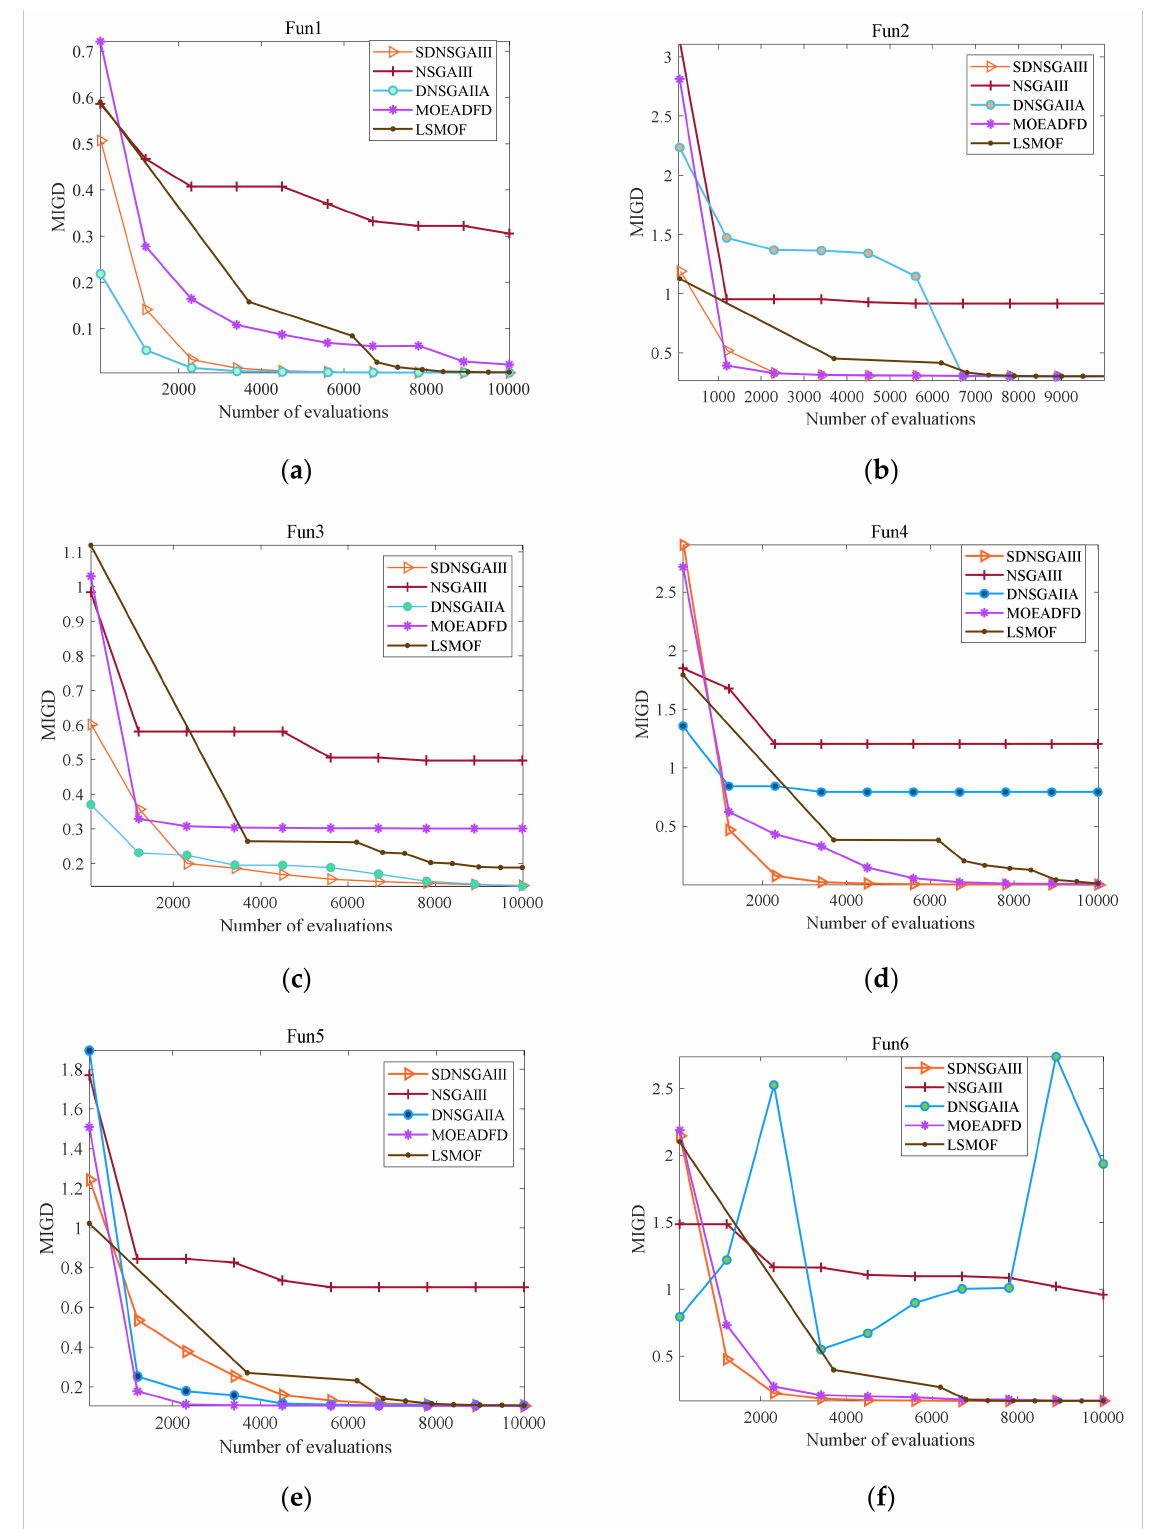
Figure 2. The MIGD trend of five algorithms with n t = 10, τ T = 20. ( a – f ) are MIGD trend graphs of six functions,